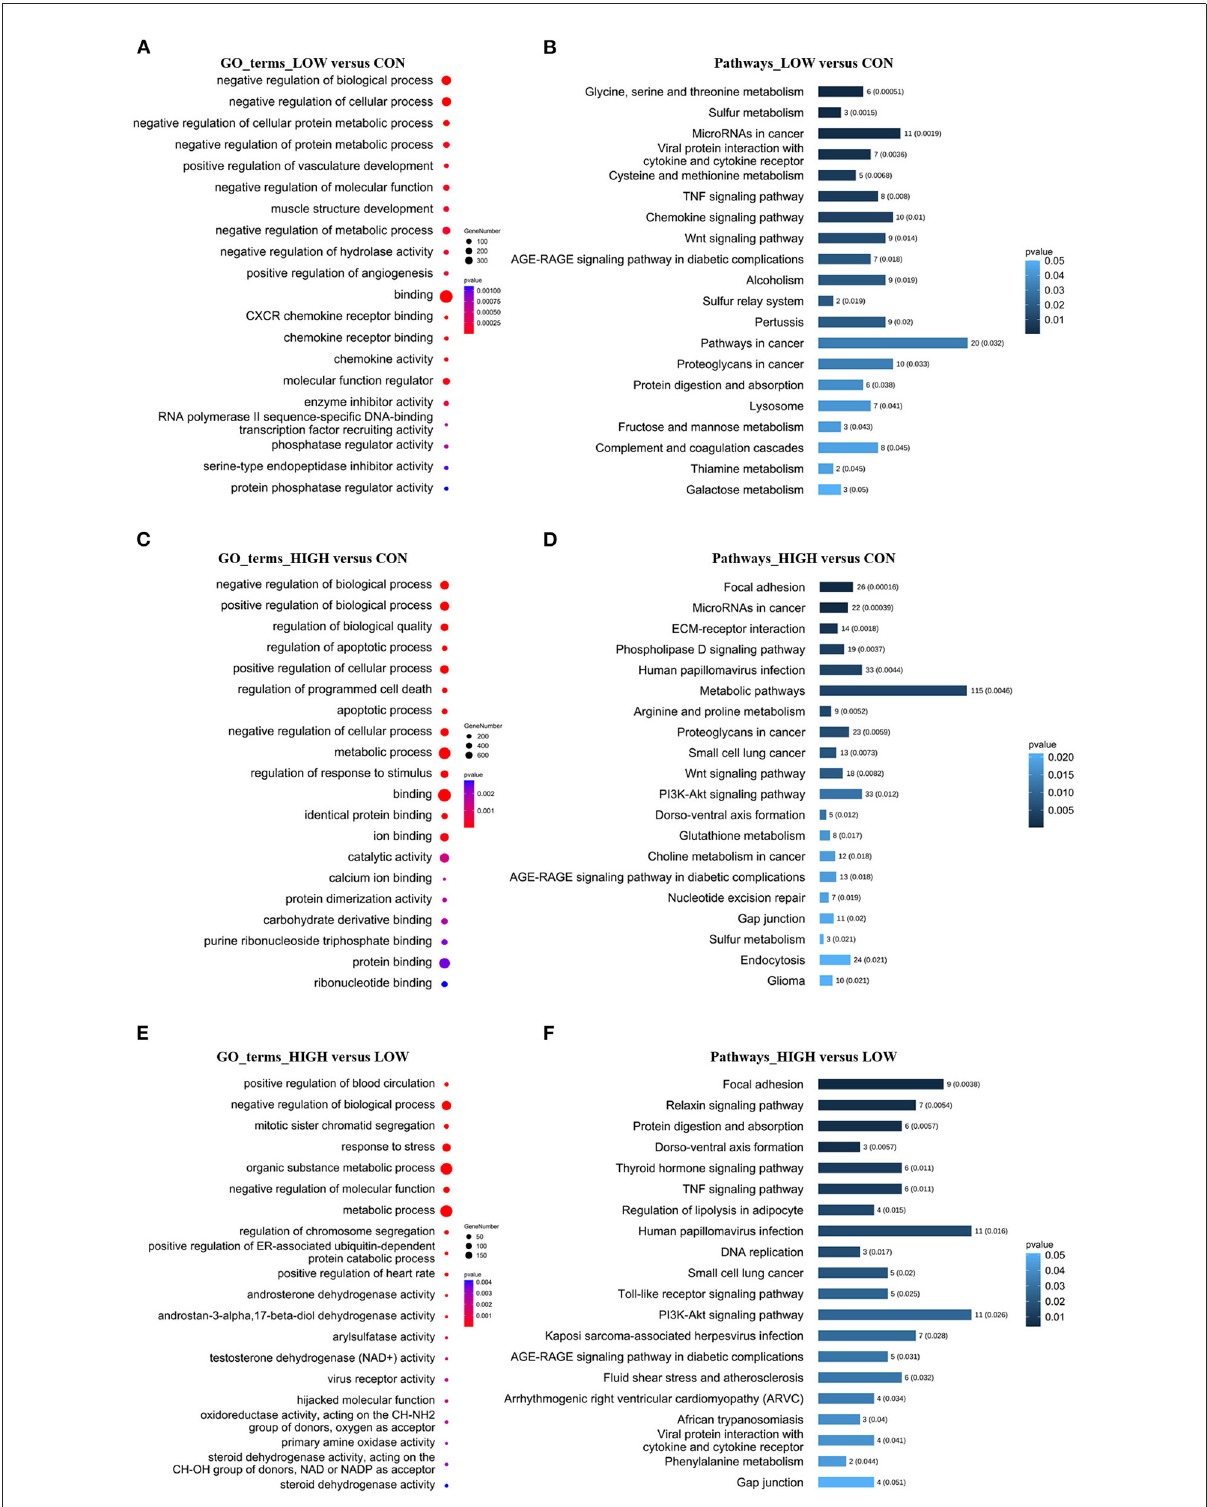
FIGURE6 GO and KEGG Analyses of differentially expressed lncRNA target genes in POGCs in different RES-treatment groups. (A, C, E) GO categories (biological process, molecular function) of target genes for DELs. (B, D, F) KEGG analysis of target genes for DELs. The size and color of each bubble represents the number of genes in each GO terms and p -value,